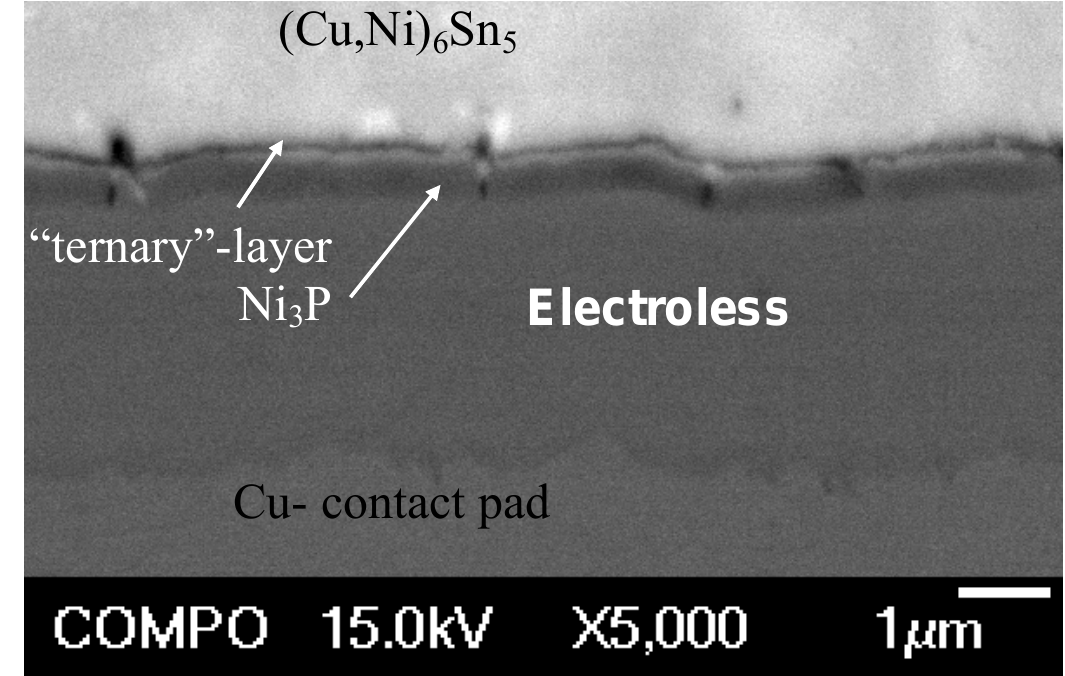
Figure 4. SEM micrograph revealing the presence of two reaction layers between the IMC and Ni[P]